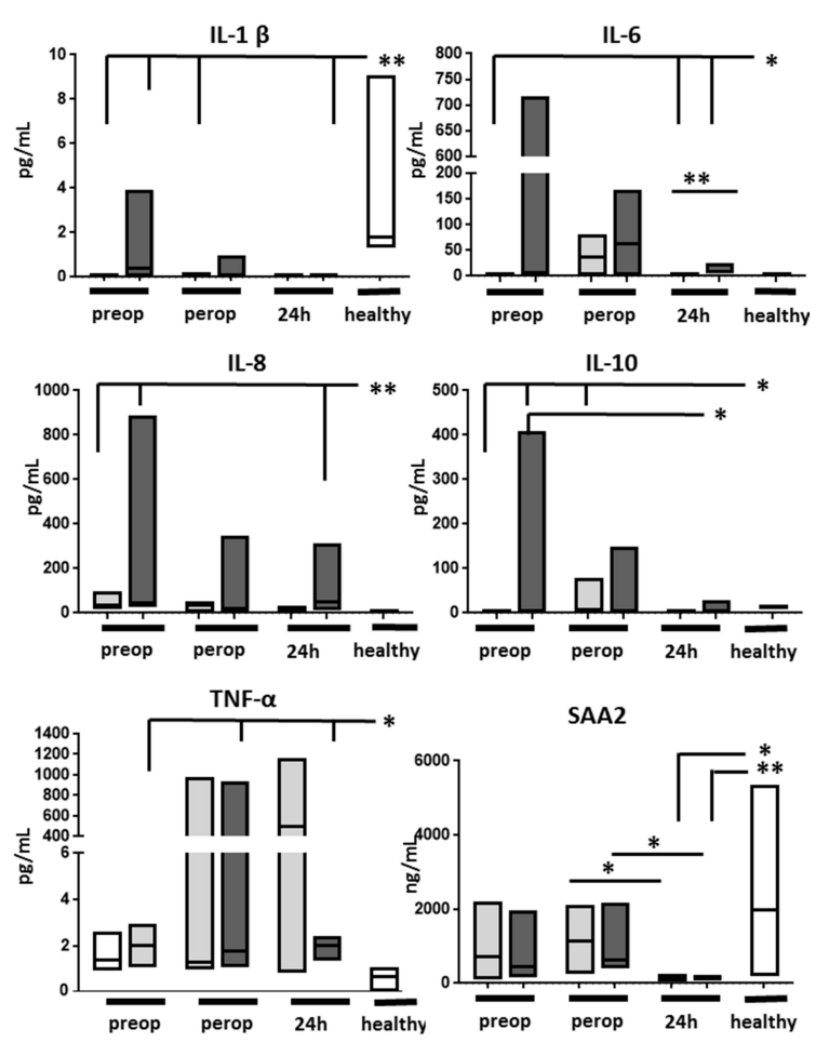
Figure 5. Serum concentration of several cytokines and serum amyloid A2 (SAA2) in patients without (light grey bars) and with acute kidney injury (dark grey bars) and in a group of healthy controls (white bars, n = 6). IL—interleukin, IFN—interferon. Lowest limits of detection were as follows: IFN- γ : 0.37 pg/mL, IL-1 β : 0.05 pg/mL, IL-2: 0.09 pg/mL, IL-4: 0.02 pg/mL, IL-6: 0.06 pg/mL, IL-8: 0.07 pg/mL, IL-10: 0.04 pg/mL, IL-12p70: 0.11 pg/mL, IL-13: 0.24 pg/mL, TNF- α : 0.04 pg/mL. * p < 0.05; ** p <